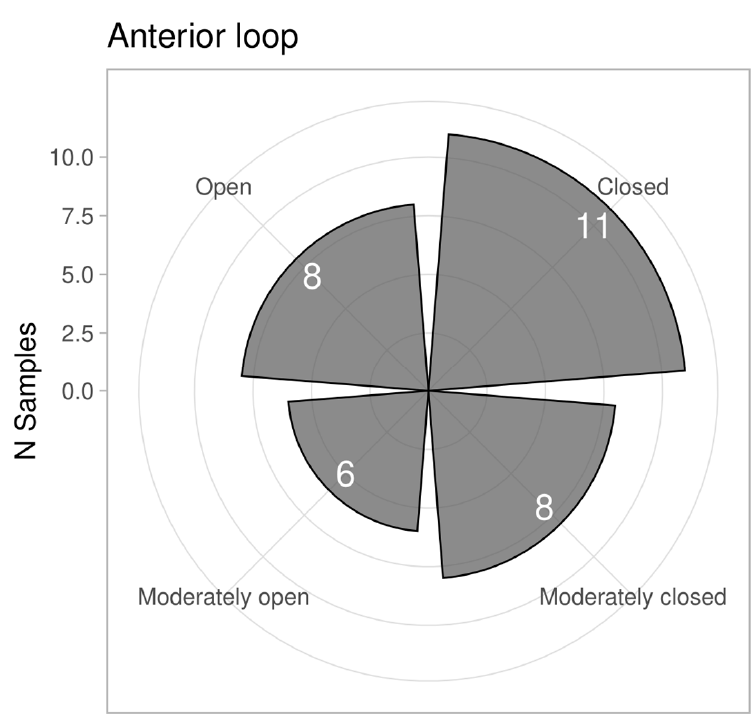
Figure 4. Samples collected in the Montefalco sampling site and genotyped through mtDNA analysis. Statistical analyses and graphical elaborations were carried out with the R statistical framework (cran.r-project.org) (accessed on 14 March 2023) within the RStudio Develop- ment Environment (rstudio.com) (accessed on 14 March